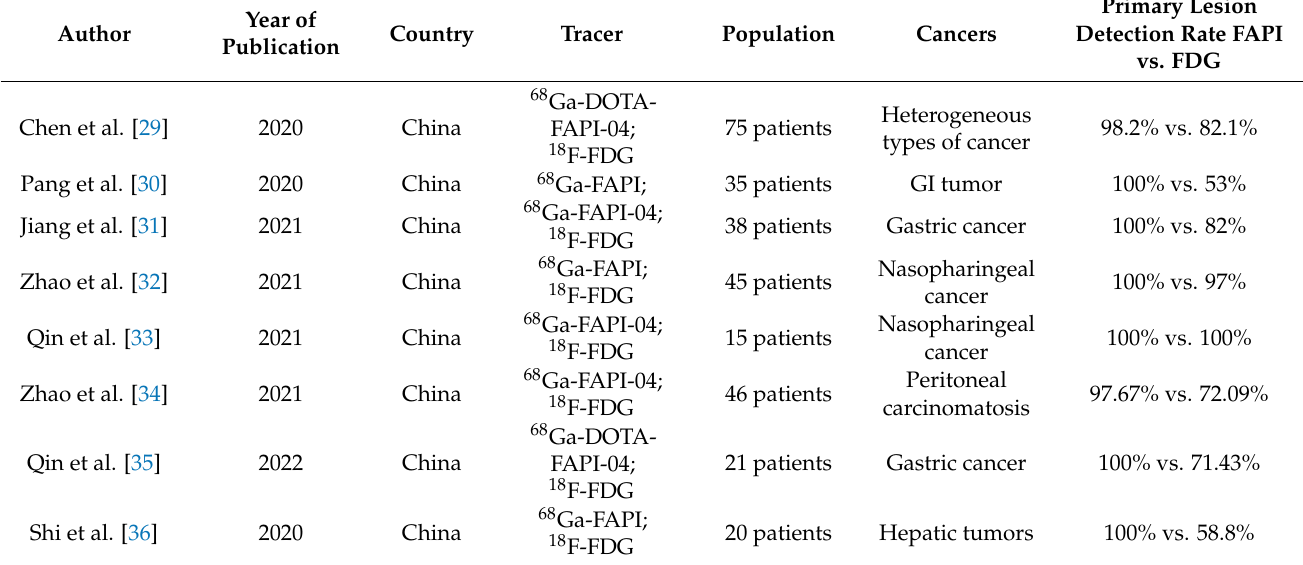
Table 3. Direct comparison of detection rate of FAPI vs. FDG in various types of